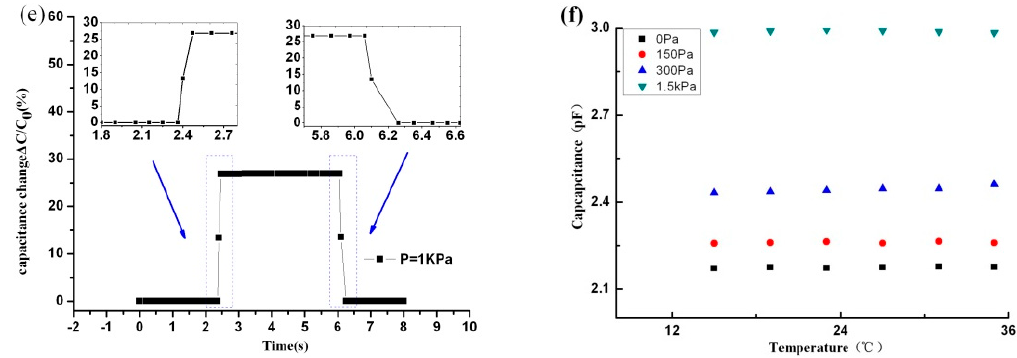
Figure 4. Characterization of the capacitive pressure response of the pressure sensor. ( a ) Sensitivity with different sensing area (size = 4 × 4 mm 2 , 6 × 6 mm 2 , and 8 × 8 mm 2 , respectively); ( b ) Capacitance–time curve for the detection of pressure (100 Pa) according to the loading and unloading of a little stone (0.7 g); ( c ) Bending stability of pressure response after 500-cycle bending test; ( d ) Multi-cycle tests of dynamic loading/unloading pressure with different values; ( e ) Fast response and relaxation time (<200 ms) of the sensor; ( f ) The curve of thermal drift of the sensor.